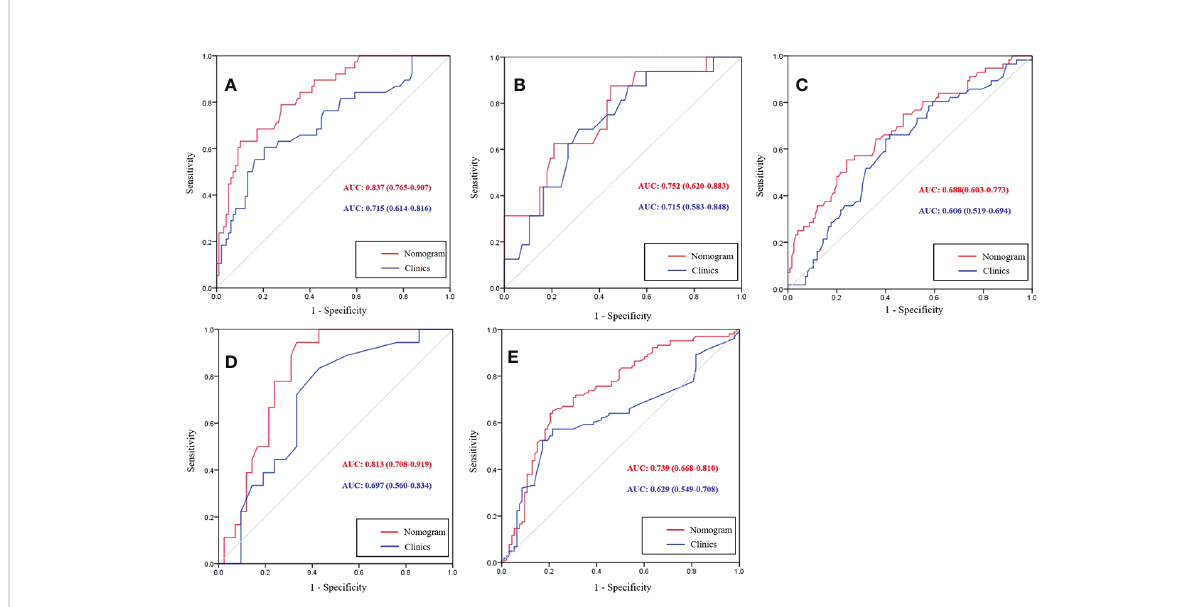
FIGURE 6 Receiver operating characteristic (ROC) curves of the nomogram and clinical model for differentiating extranodal extension (ENE) positive from lymph node metastasis (LNM) negative (A) , lateral lymph node positive from LNM negative (B) , and N2 stage from LNM negative (C) . At T1-T2 stage subgroup analysis, ROC curves of nomogram and clinical model for predicting LNM (D) . At T3 stage subgroup analysis, ROC curves of a clinical-radiomics nomogram and clinical model for predicting LNM (E)